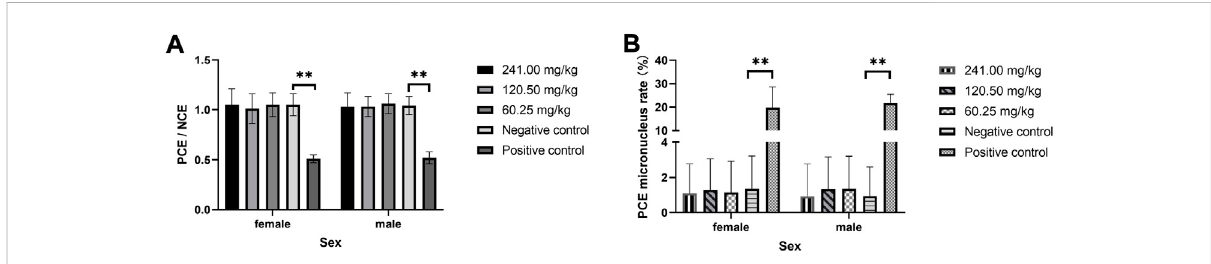
FIGURE 1 EffectofMPTAonbonemarrowmicronucleustestinmice(n=20,females=10,males=10) (A) EffectofMPTAonPCE/NCEvalues; (B) Effectof MPTA on PCE micronucleus rate. Data are compared with negative controls, and * indicates signi fi cant differences ( p < 0.05).